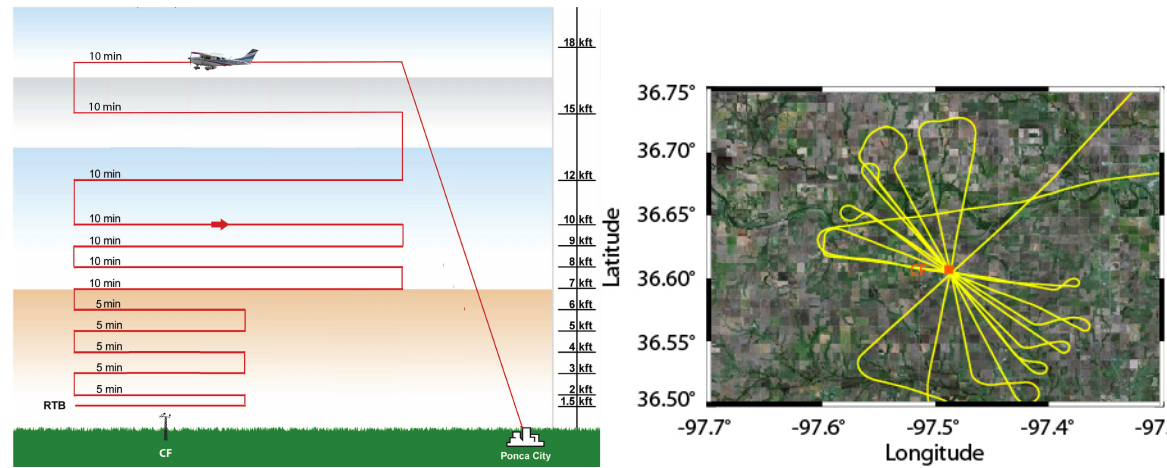
Fig. 1. (Left) Vertical flight pattern for flights deployed over the ARM/SGP from 460m to 5500ma.m.s.l. (Right) Horizontal projection of flight pattern centered on the tower of ARM/SGP, overlayed over a true color land cover picture of the region. Red square shows the location of the SGP central facility 60m tower. Orientation of the flight pattern depends on prevailing winds and changes with altitude to avoid contamination by platform exhaust. Yellow lines show the flight path for a typical flight (24 October 2011).